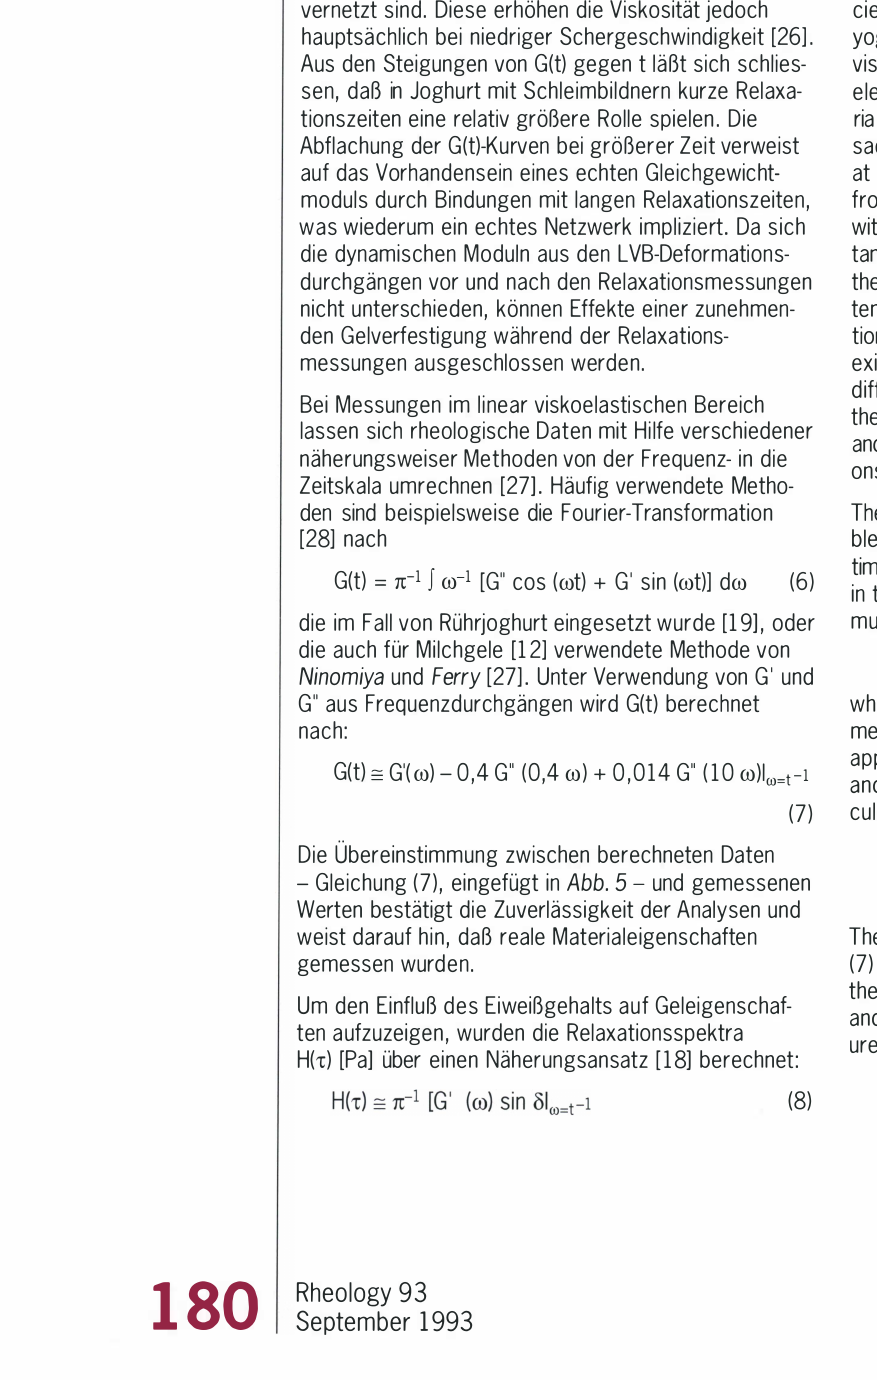
Fig. 5: Relaxation modulus as a function of time. Lines: measured values; Symbols: G(t} calculated from dynamic moduli by equation